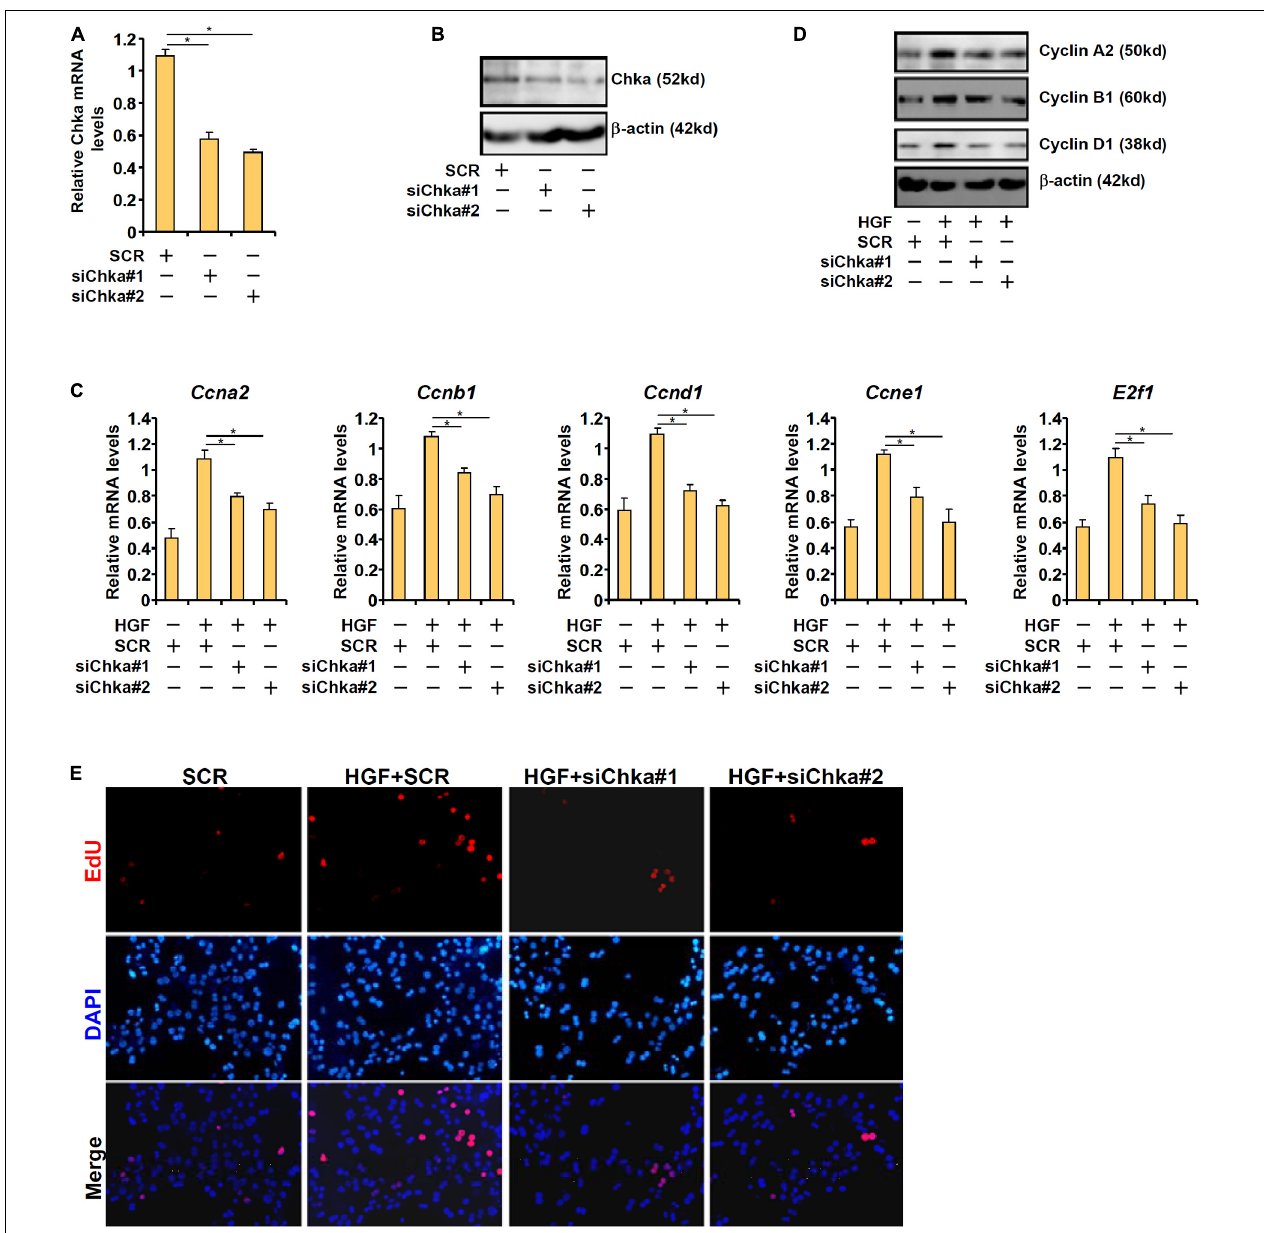
FIGURE 2 | Choline kinase alpha is necessary for HGF-induced proliferation of hepatocyte. (A,B) Primary hepatocytes were transfected with indicated siRNAs and harvested 24 h after transfection. Chka expression was examined by qPCR and Western blotting. (C–E) Primary hepatocytes were transfected with indicated siRNAs followed by treatment with HGF for 24 h. Cell proliferation was examined by EdU staining. Pro-proliferative gene expression was examined by qPCR and Western blotting. * p <